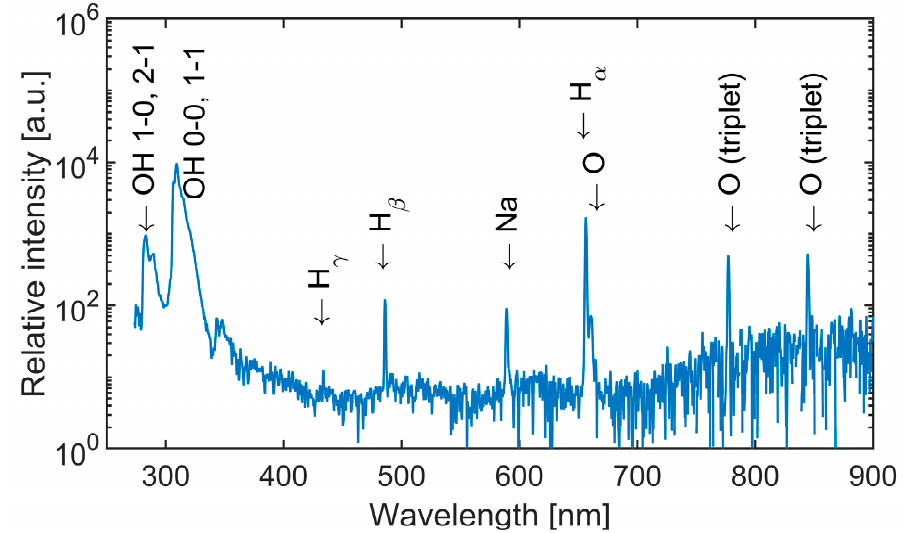
Figure 5. Survey of the optical emission spectrum of the HCPJ generated at 400 W input power and 40 kPa pressure. Position is above the outlet of the nozzle.